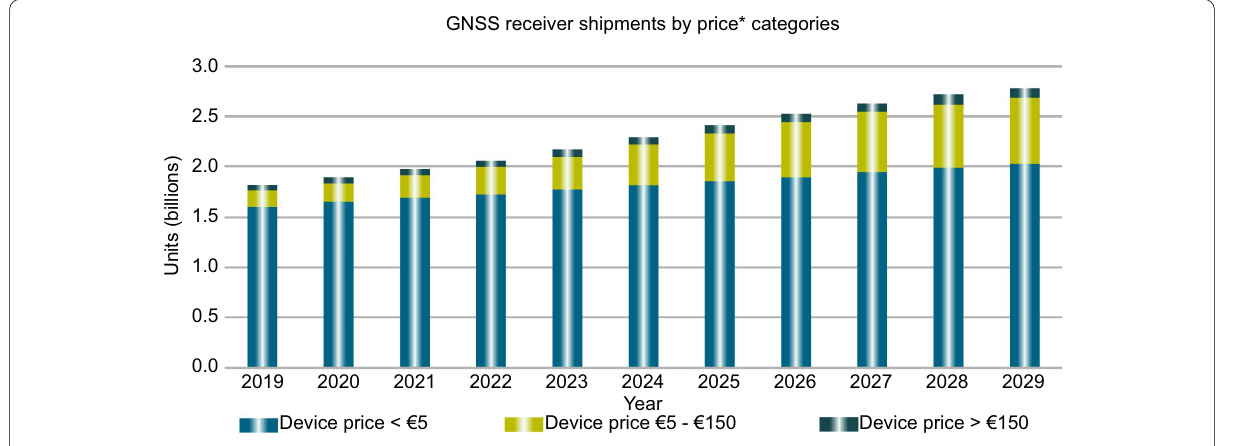
Fig. 1 Global annual GNSS receiver shipments from 2019 to 2020 (European GSA,